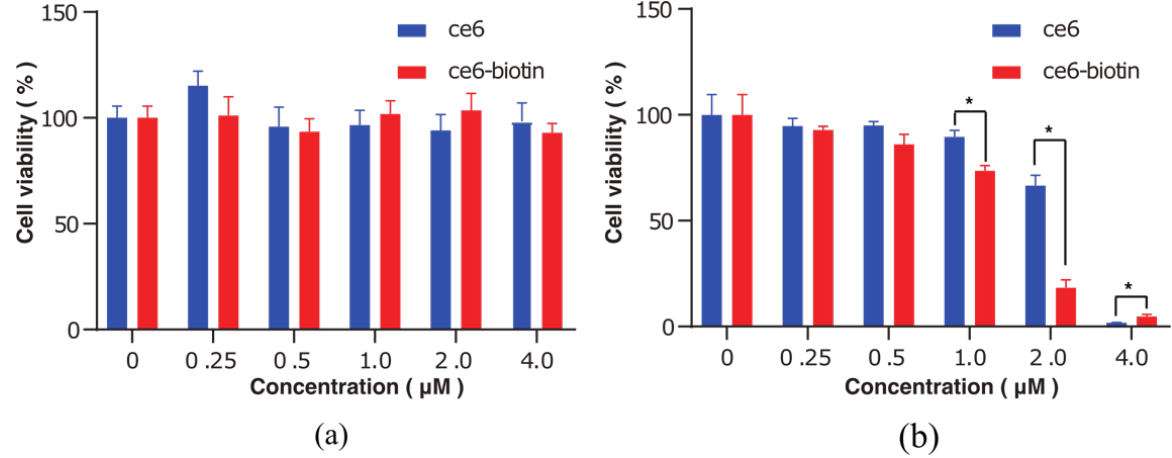
Figure 6. Cytotoxicity against HeLa cells of Ce6 and Ce6-biotin in the dark ( a ) or upon irradiation ( b , λ = 655 nm). p -values < 0.05 are denoted with asterisks (*).